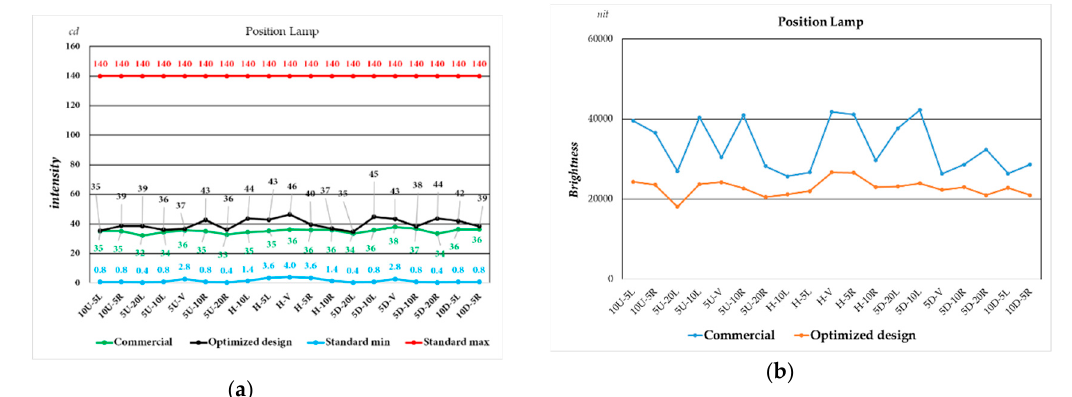
Figure 14. The comparison with respect to each considered angle of EU ECE regulation between the new optimized position lamp prototype and the commercial sample; ( a ) measured optical intensity; ( b ) measured optical brightness.